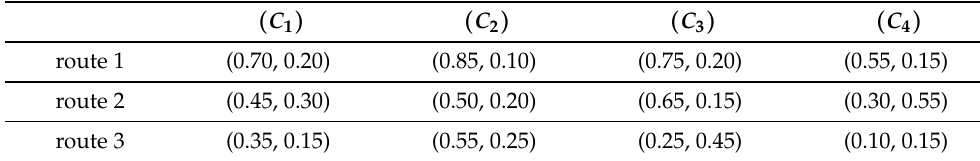
Table 1. Decision matrix acquired from